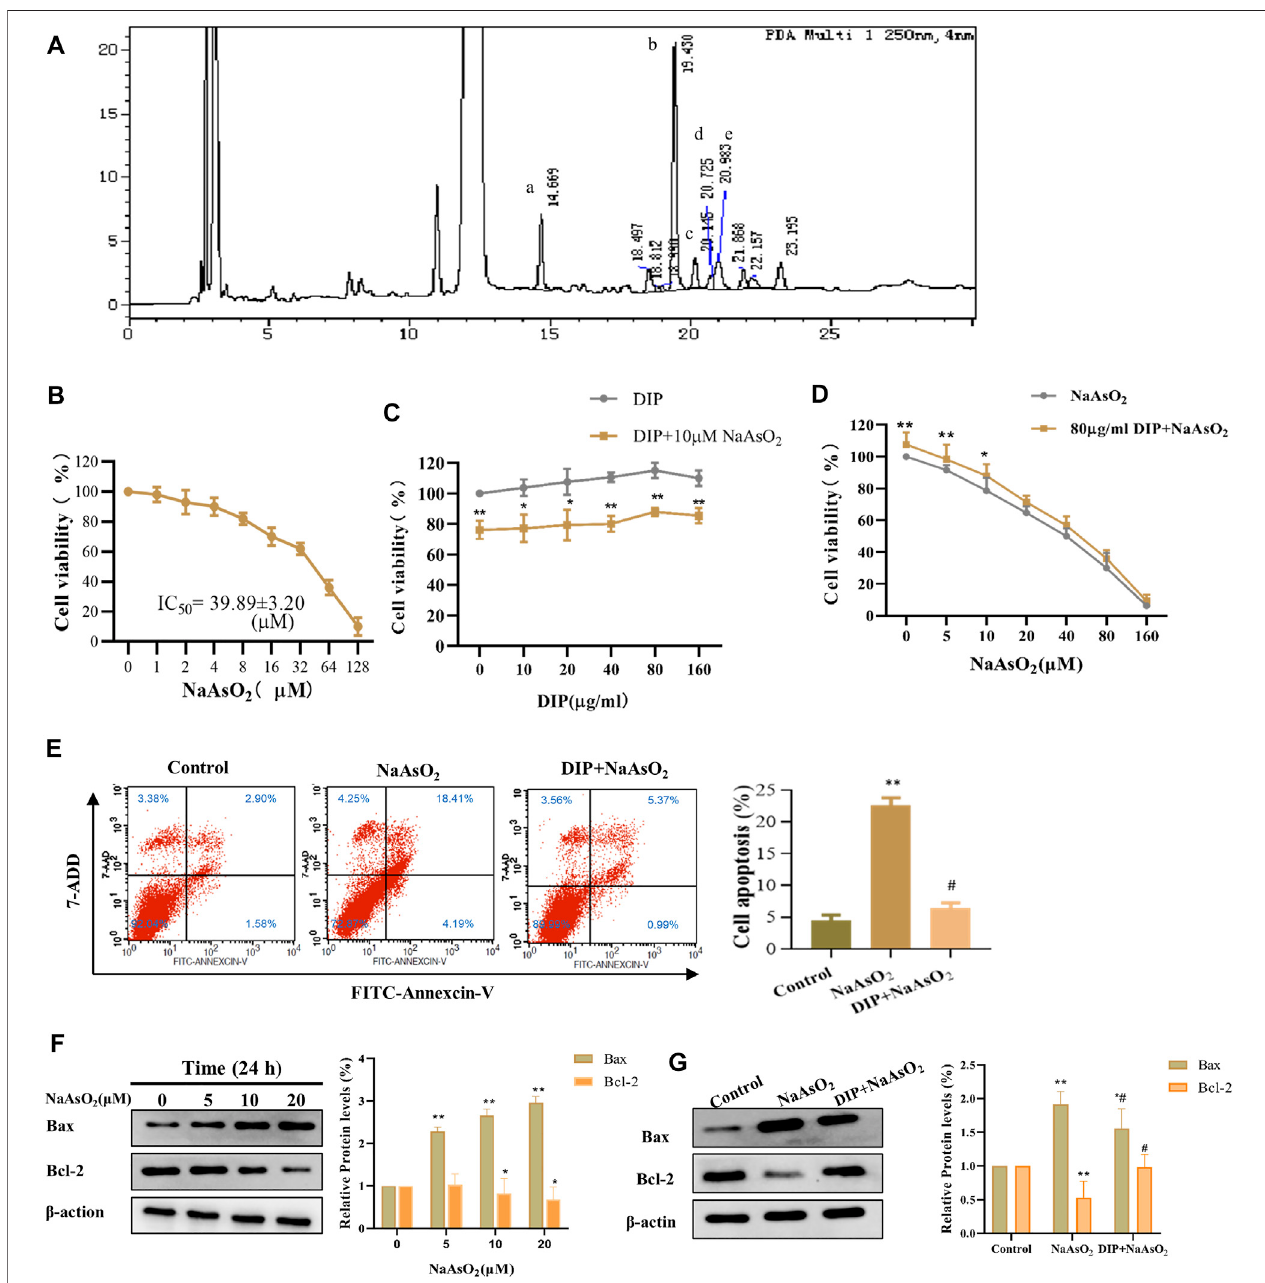
FIGURE1| DIPagainstNaAsO 2 -inducedhepatotoxicityinL-02cells. (A) HPLCpro fi leofsporocarppolysaccharideofDictyophora.(a)D-mannose. (b)D-glucose. (c) D-galactose. (d) D-xylose. (e) L-fucose. (B) The viability of L-02 cells treated with different concentrations of NaAsO 2 (CCK-8 assay). (C) The viability of L-02 cells exposed to arsenic (10 μ M NaAsO 2 ) with or without pretreatment with different concentrations of DIP. (D) The viability of L-02 cells pretreated with DIP (80 μ g/ml) and then exposed to different concentrations of NaAsO 2 . (E) Flow cytometry pro fi les showing the distribution of cells (Left) . Plot showing the proportion of apoptotic cells (Right) . Compared with control group, ** p < 0.01; compared with NaAsO 2 group, # p < 0.05. (F) Western blot analysis of Bax or Bcl-2 protein expression levels when treated with different arsenic concentrations (Left) . Plot showing Bax or Bcl-2 protein expression levels (Right) . ( G ) Western blot analysis of Bax or Bcl-2 protein expression levels when pretreated withDIPand thentreatedwith arsenic (Left) .Plot showing Baxor Bcl-2 protein expression levels (Right) . Compared withthe control group, * p < 0.05, ** p < 0.01. Compared with the control group, * p < 0.05, ** p < 0.01; compared with NaAsO 2 group, # p < 0.05.